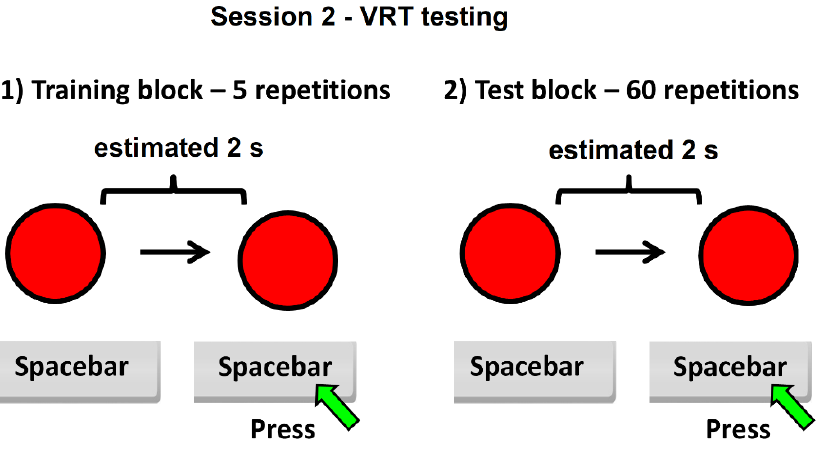
Figure 2. Schematic of session 2 of the experiment - VRT testing.